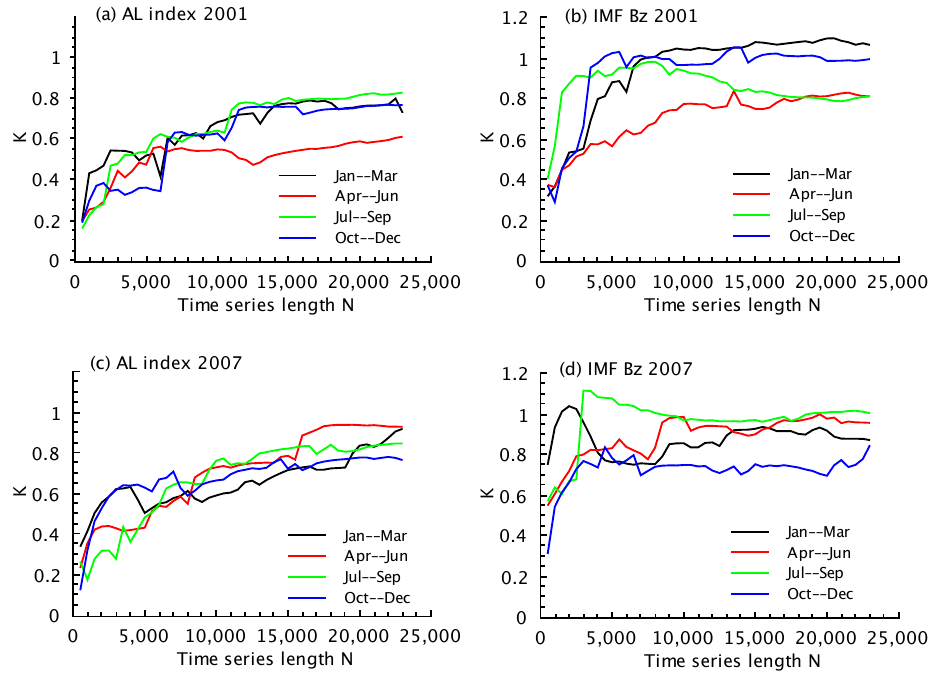
Fig. 2. The values of K versus the time series length N for different time windows of AL index and IMF B z during 2001 and 2007. 6 Devi, et al.: Deterministic dynamics of the magnetosphere: The 0-1 test